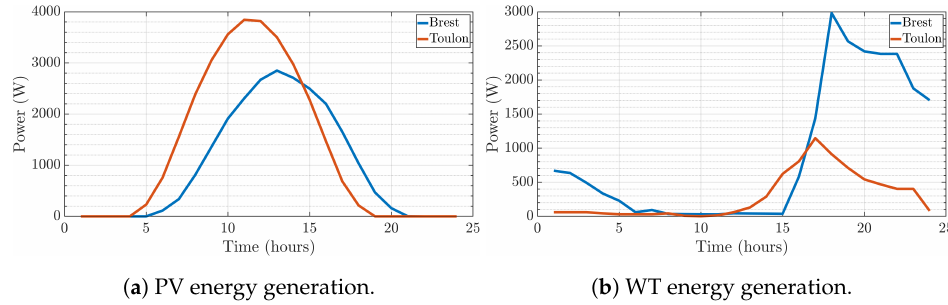
Figure 6. Case study 1: Renewable energy resources energy generation in Brest and